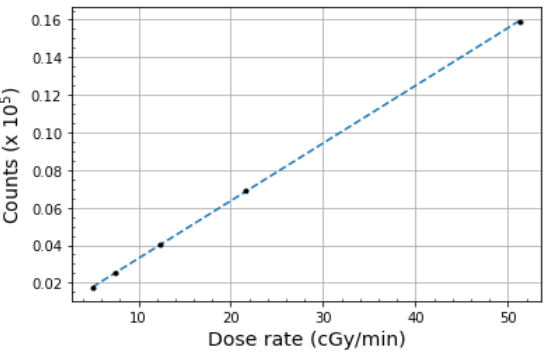
10 Figure 10. Dose linearity results. The relationship between OSLD response and absorbed dose. For each data point, a single OSLD was irradiated, kept in the dark for a minimum of 10 min, and then readout. The solid orange line represents OSLD linear response to dose. Meanwhile, the blue dashed curve models the data obtained from this experiment and is described by Equation (1). 3.3. Dose Rate Dependence Using a single catheter, a fixed dwell time of 250 s was used to deliver a dose of 213.6 cGy to the initial 4 cm source-to-OSLD distance. As the source-to-OSLD distance in- creased, the dwell time remained fixed. Figure 11 exhibits how OSLDs are independent of dose rate as the relationship between OSLD response (i.e., counts) and dose rate is lin- ear, with an R 2 of 0.9999, thus indicating an excellent fit. The OSLD response is modeled by the following equation: Dose rate (cGy/min) = (3 × 10 −4 )(𝑐𝑜𝑢𝑛𝑡𝑠) − 0.7383 , (2) which is displayed as the dashed line in Figure 11. Single-factor ANOVA testing compar- ing the effect of dose rate to measured counts revealed that there was a statistically signif-